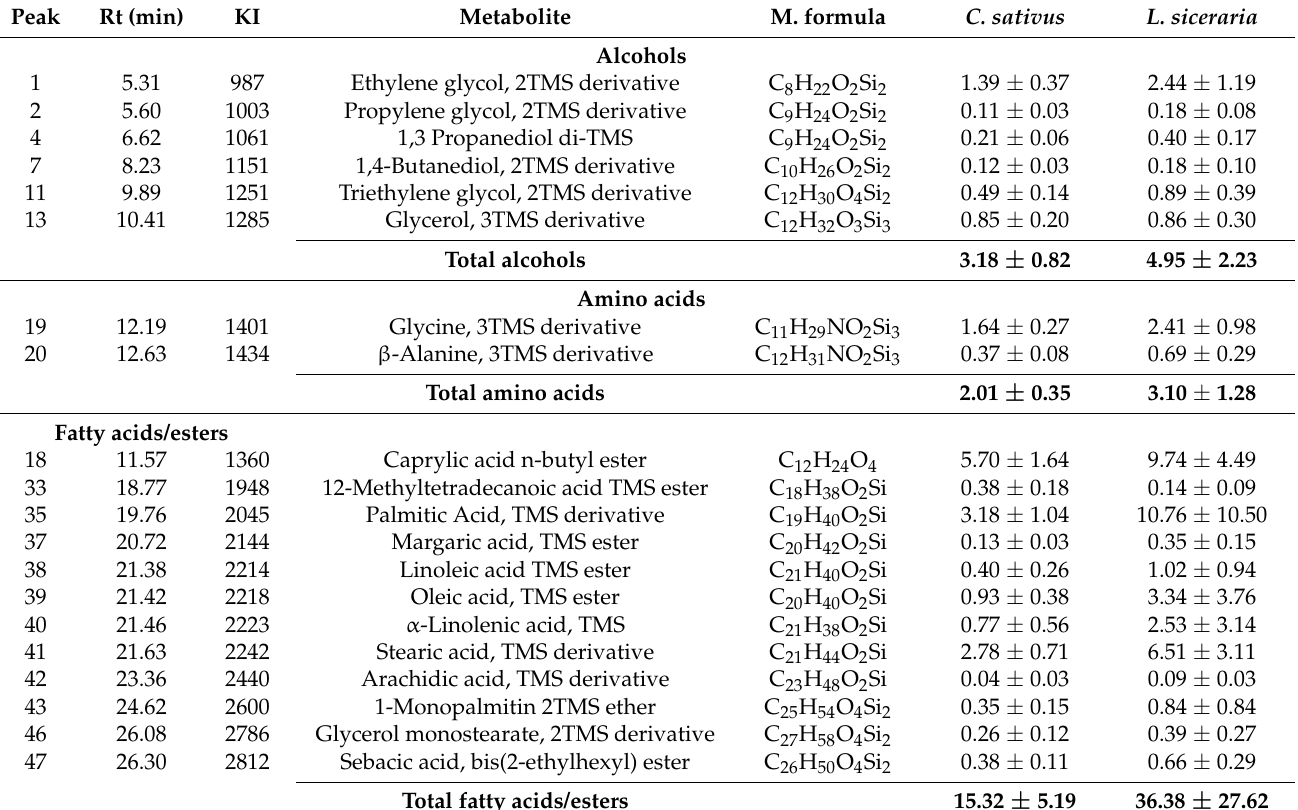
Table 2. Primary metabolite analyzed using GC-MS of different C. sativus and L. siceraria with results expressed as relative percentile of the total peak area (n =